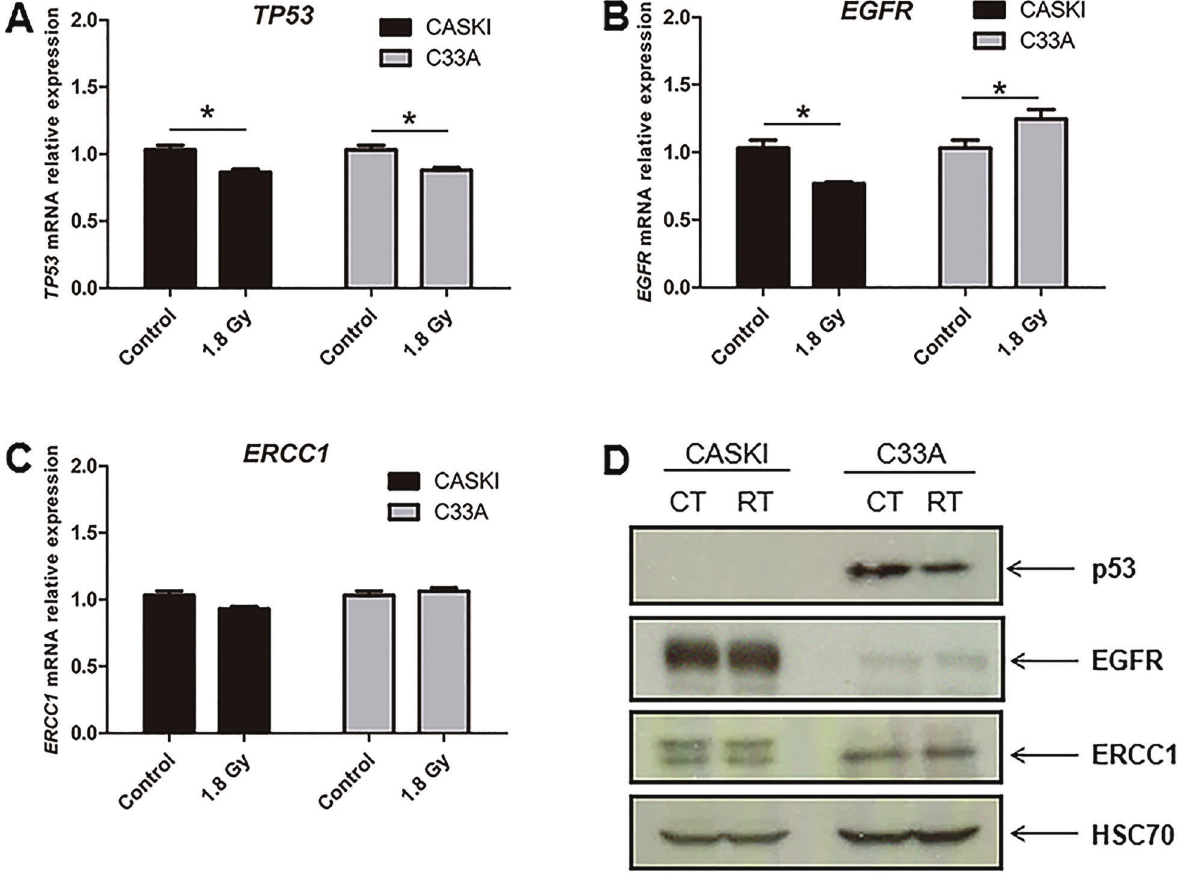
Figure 2. Gene expression modulation induced by radiation in cervical cancer cell lines. Gene expression assays for TP53 ( A ), EGFR ( B ), and ERCC1 ( C ) were evaluated by quantitative polymerase chain reaction (qPCR). GAPDH was used as a housekeeping gene. Cell lines were incubated in serum-free medium for 4 h followed by irradiation (1.8 Gy). After 24 h of treatment, total RNA was extracted, converted into cDNA and the speci fi c sequences ampli fi ed by real-time PCR. The relative expression level of mRNA was calculated using the comparative C T method (2 (cid:1) DD CT ). *P o 0.05 (two-tailed unpaired t -test). Data are reported as means ± SD. D , Cells were incubated in serum-free medium for 4 h followed by radiotherapy (1.8 Gy). After 24 h of treatment, cells were lysed and the levels of p53, EGFR and ERCC1 proteins were determined by western blotting. HSC70 was used as a loading control. CT: control, RT: